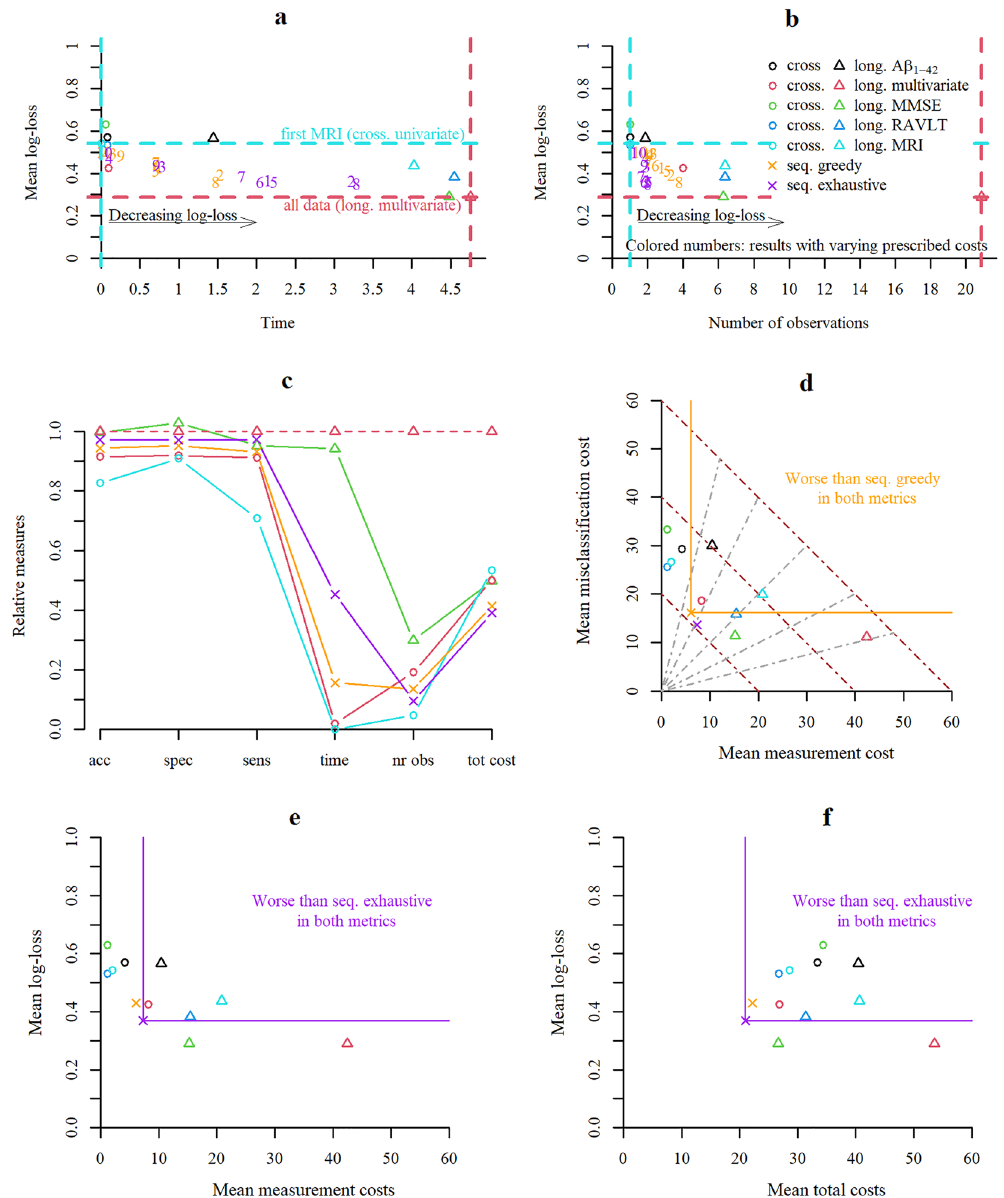
Figure 5. Multi-objective evaluation. Quantitative comparison of sequential and non-sequential i.e., univariate, or multivariate cross-sectional (cross.) or longitudinal (long.) classification strategies. ( a ) Mean follow-up time of a strategy and resulting mean log-loss. Scattered numbers 1 to 10 correspond to results obtained with tuples of prescribed costs (time; MRI; Aβ 1-42- CSF ; cognitive test); 1: (2; 2; 4; 1), 2: (1; 2; 4; 1), 3: (4; 2; 4; 1), 4: (8; 2; 4; 1), 5: (2; 1; 2; 0.5), 6: (2; 4; 8; 2), 7: (2; 8; 16; 4), 8: (1; 1; 2; 0.5), 9: (4; 4; 8; 2)., 10: (8; 8; 16; 4). ( b ) Mean number of observations of a strategy and resulting mean log-loss. ( c ) Strategies in relation to the multivariate longitudinal (for some selected strategies). Performances (accuracy, specificity, and sensitivity) of different strategies divided with the one from the multivariate longitudinal strategy are displayed (represent portion of retained performance). Moreover, the ratios of mean follow-up time or number of observations to the one of the multivariate longitudinal strategies were computed (represent portion of utilized resources). The ratio of the total cost of strategies with the one using all information is also displayed in the right end of the figure (summarizing accuracy and costs of different sources). ( d ) Two-objective evaluation using the metrics mean misclassification costs and mean measurement costs. Brown dotted lines represent points with same mean total costs and grey dotted lines represent the shares of misclassification and measurement costs from the total costs (middle line: same misclassification and measurement cost, rotated left: higher share of misclassification costs, rotated right: higher share of measurement costs). ( e ) Two-objective evaluation using the metrics mean log-loss and mean measurement costs. ( f ) Two-objective evaluation using the metrics mean log-loss and mean total